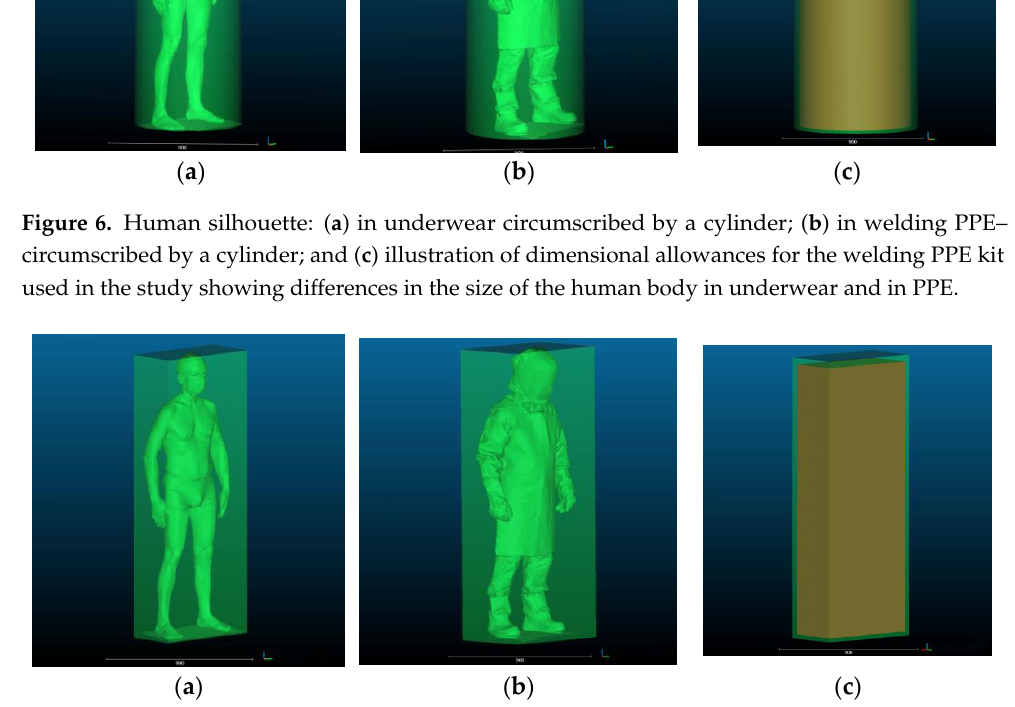
Figure 7. Human silhouette: ( a ) in underwear circumscribed by a cuboid; ( b ) in welding PPE – circumscribed by a cuboid; and ( c ) illustration of dimensional allowances for the welding PPE kit used in the study showing differences in the size of the human body in underwear and in PPE.